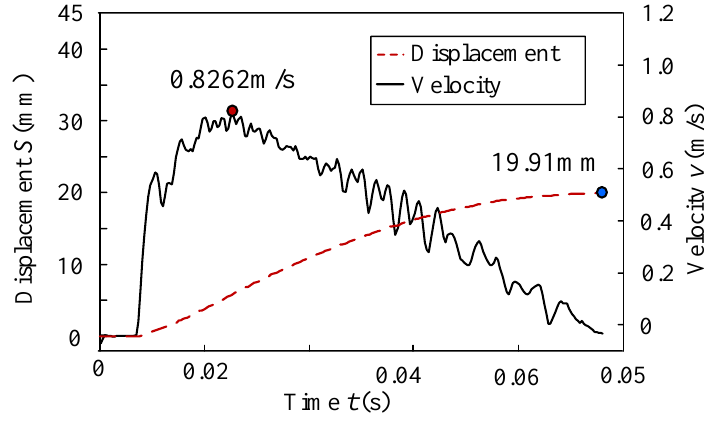
Figure 9. The displacement S and velocity v change with time.